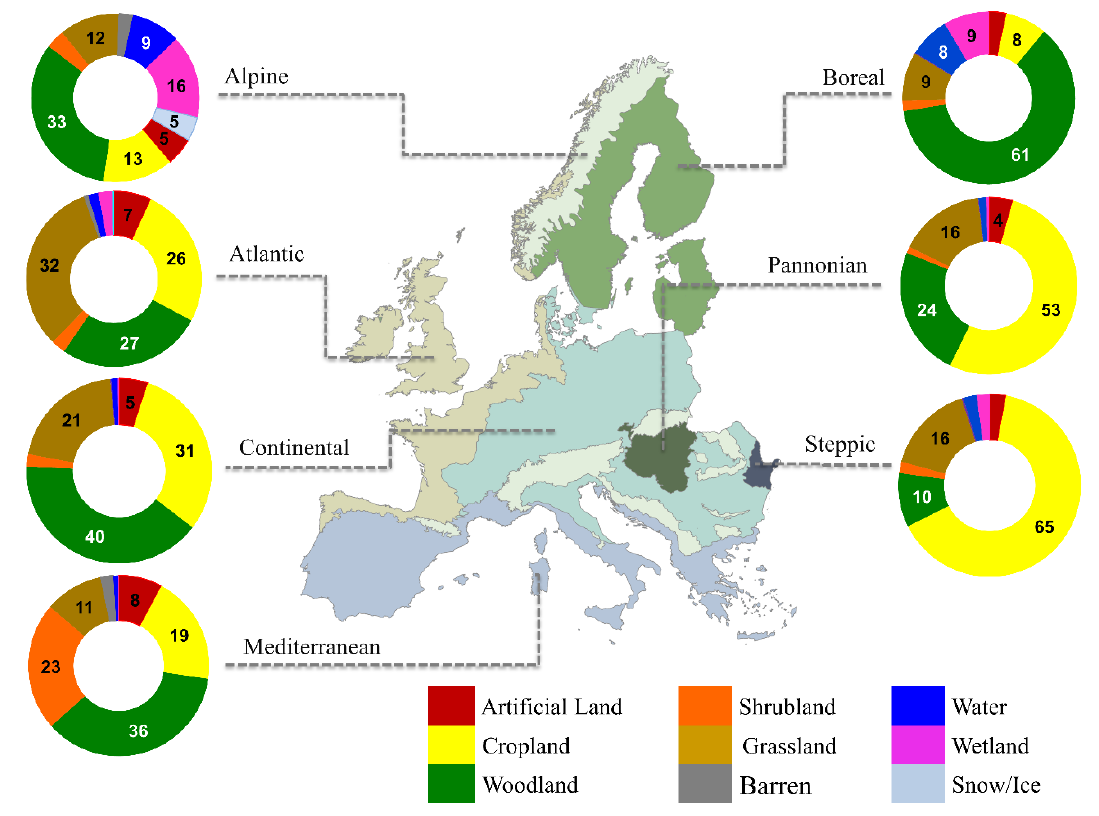
Figure 7. The portions of all nine LULC classes across the seven biogeographical regions.